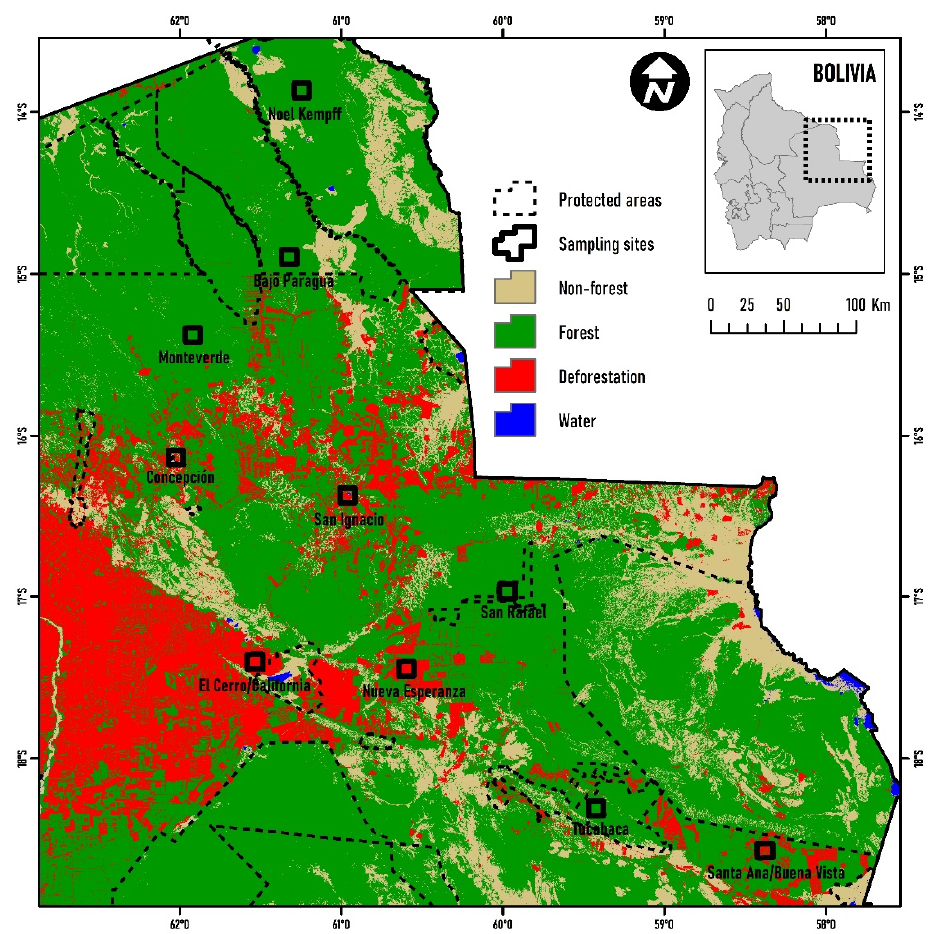
Figure 2. Sampling sites in forested and deforested areas in the Chiquitania, Department of Santa Cruz, Bolivia: land cover and deforestation until 2020, prepared by the Chiquitano Forest Conserva- tion Foundation (in Spanish FCBC). Table 1. Sampling sites selected for five areas of intact forest and five areas with deforestation in the northern and southern Chiquitania sector, Santa Cruz, Bolivia. Climate region: aridity index